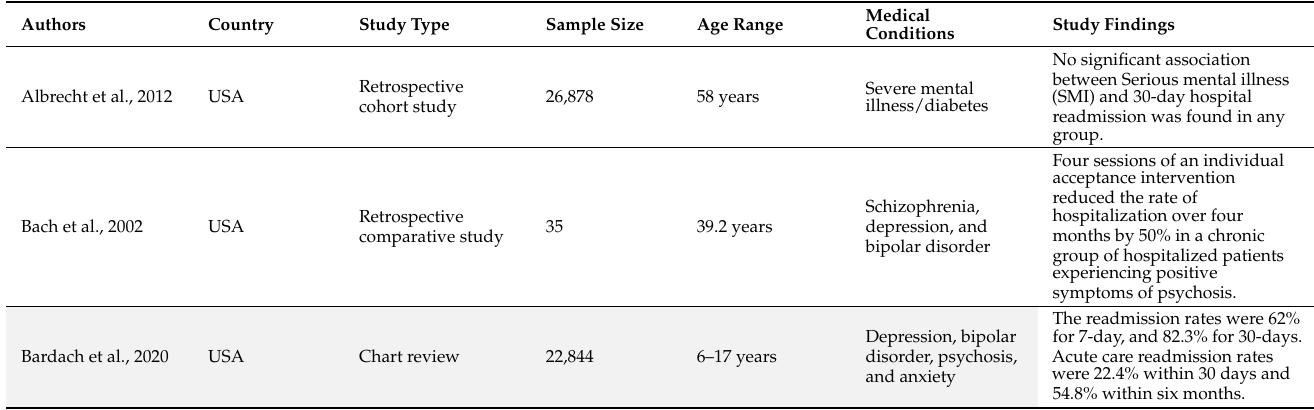
Table 1. Characteristics of included